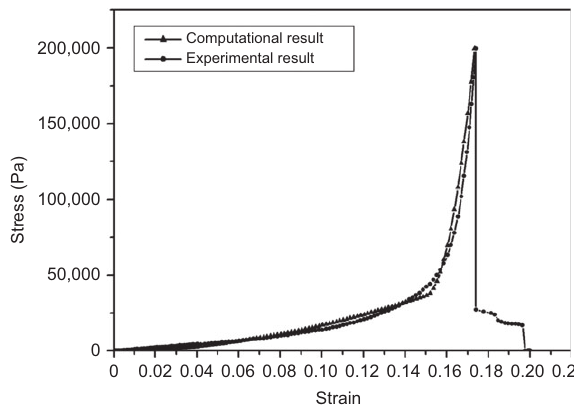
Figure 8 Experimental result and computational fit for the FRE specimen (114 mm fiber